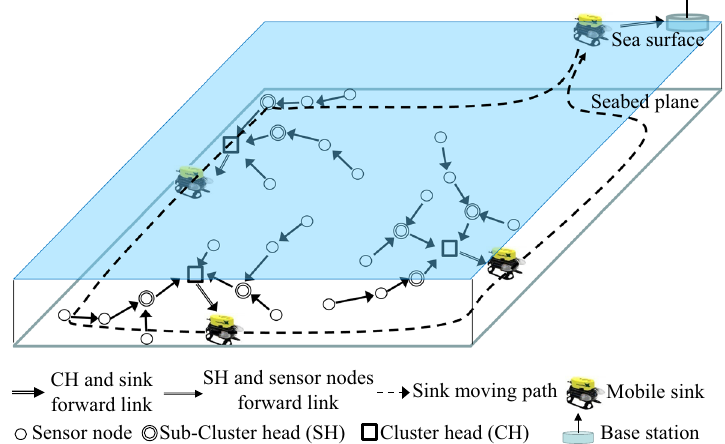
Fig. 1 Mobile sink moving path-plan diagram for the UMSN